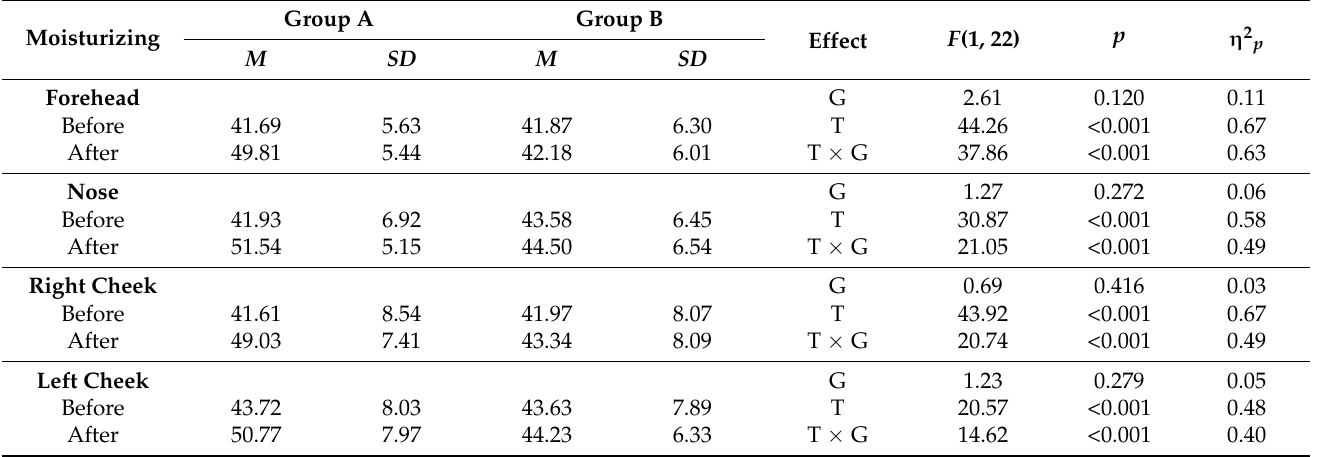
Table 2. The repeated measures one-way ANOVA for moisturizing using Corneometer CM825 (g/m 2 ).